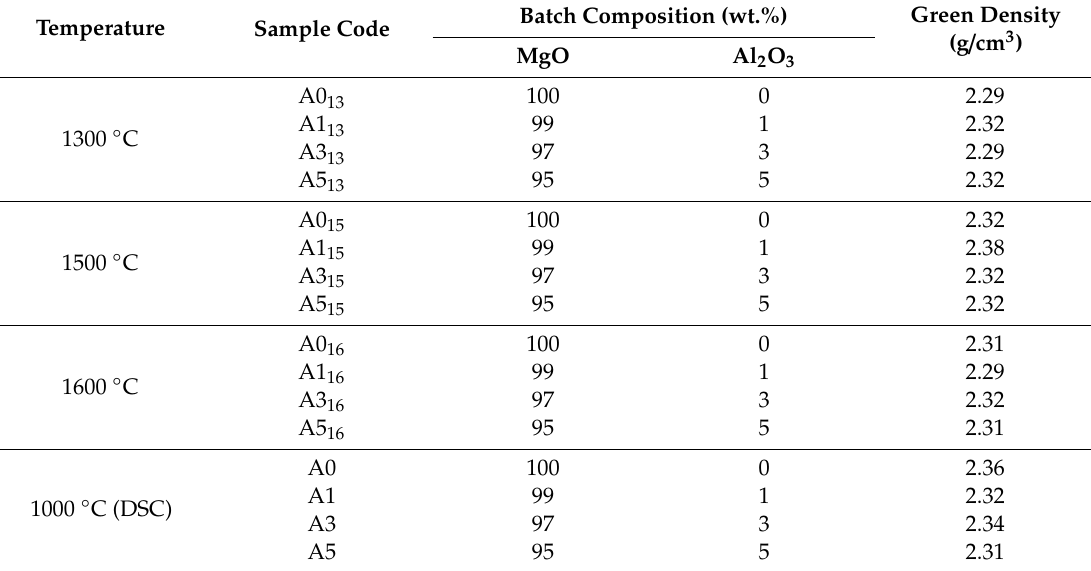
Table 3. Sintering temperature, sample codes, batch compositions with its green densities and samples used in di ff erential scanning calorimetry (DSC)